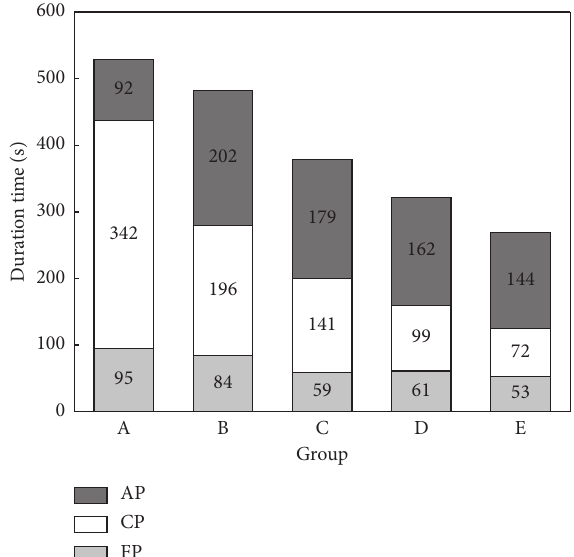
Figure 7: Proportion of the duration of the three stages for each group.